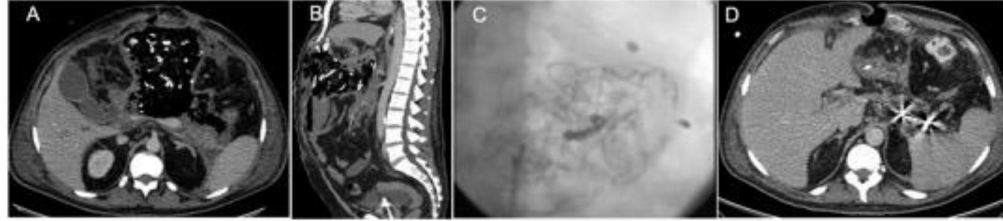
Figure 6. Splenic artery trans-arterial embolization by the placement of coils in a patient with acute pancreatitis patient submitted to an “open abdomen” tamponade for hemorrhage control. ( A ) Axial CT view, ( B ) sagittal CT view, ( C ) angiographic view post-embolization, and ( D ) axial CT control after embolization, with metal artifacts from the coils placed in the splenic